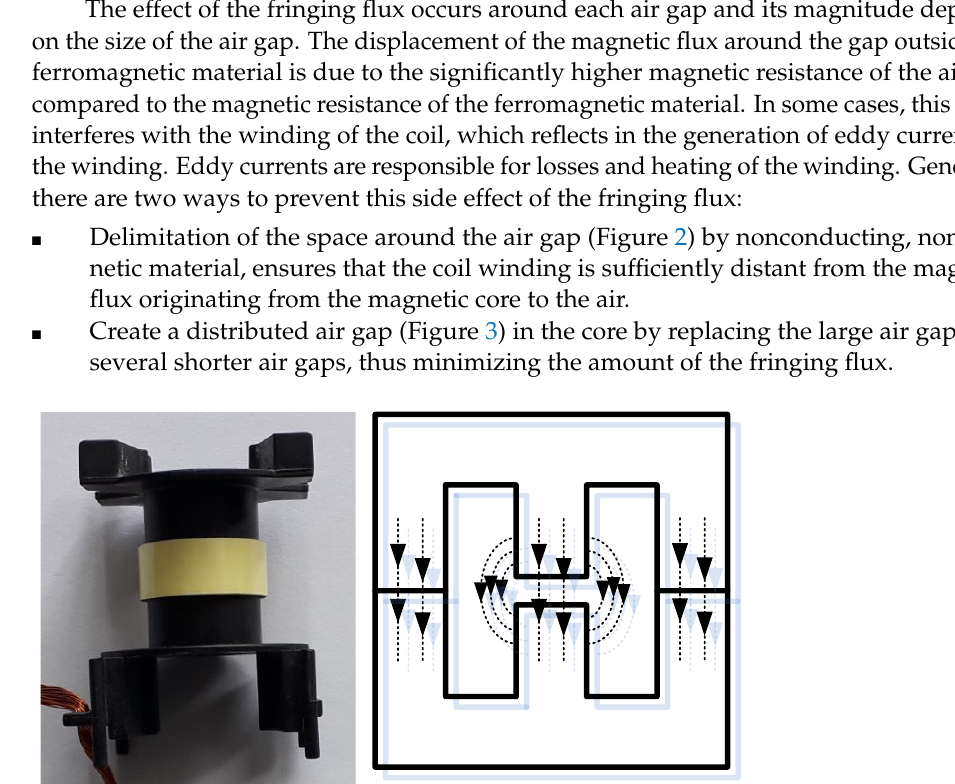
Figure 2. Example of space exclusion on the magnetic core bobbin ( left ) within the space of the core air gap ( right ).